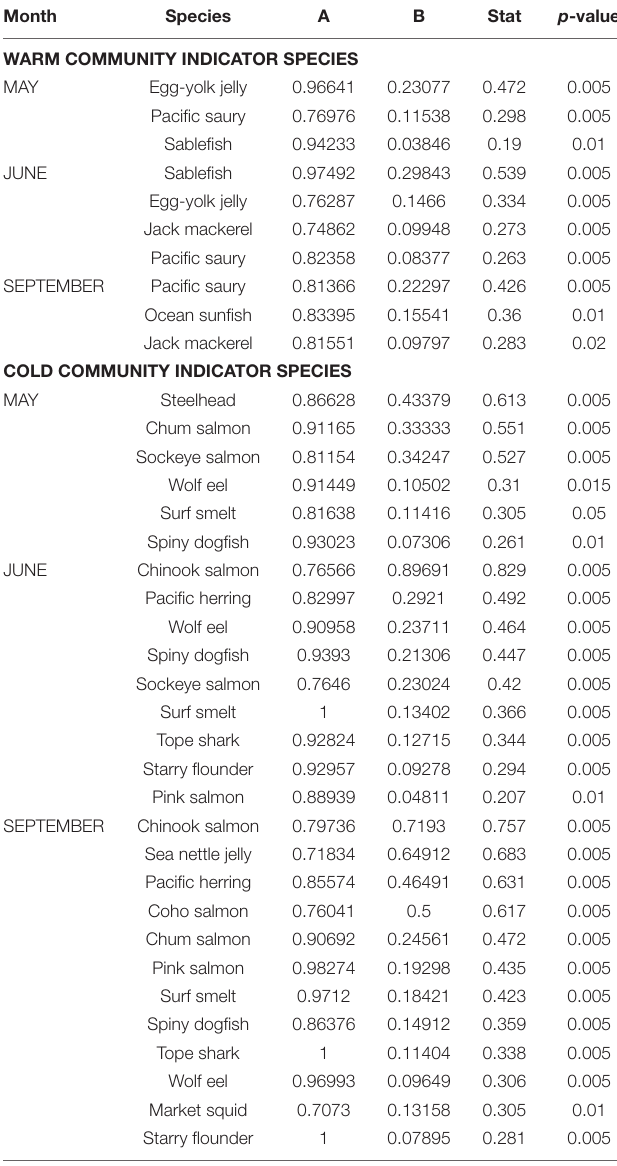
TABLE 2 | Indicator species for both warm and cold community clusters by cruise